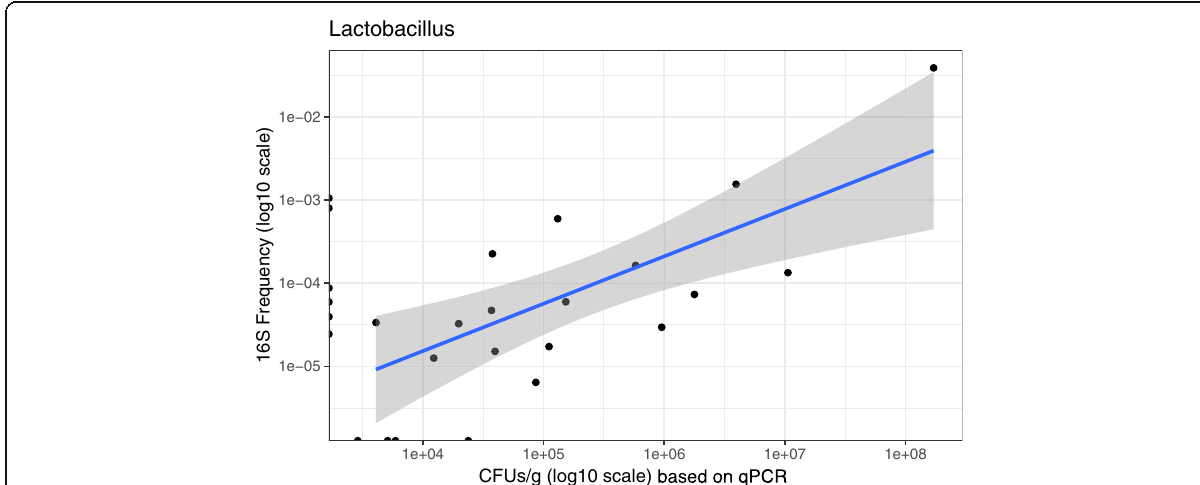
Fig. 2 Comparison of the relative abundance of Lactobacillus from 16S rRNA gene sequencing to quantification based on culture and PCR, demonstrating reasonable agreement that is consistent with expectations given the differences between the methods (Student ’ s t-test p =0.0013, R 2 =0.5334). The grey shaded area represents the 95% confidence interval around the linear regression